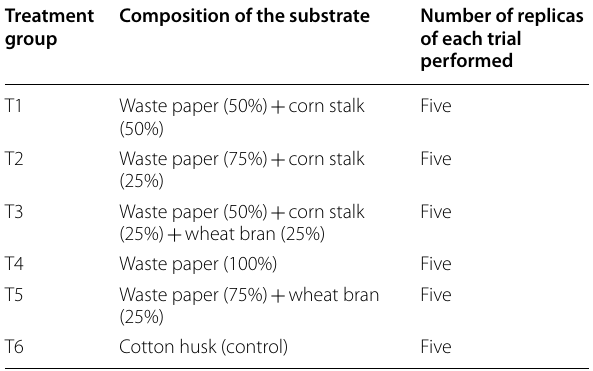
Table 1 Substrate composition of the treatment groups used